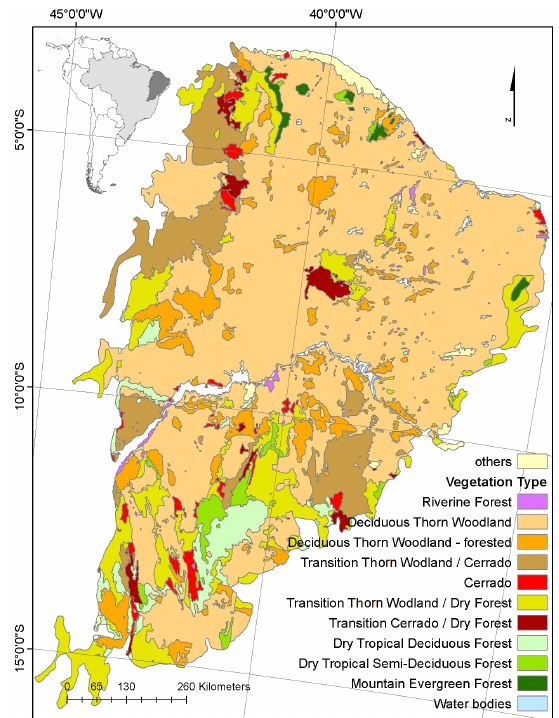
Figure 1. Caatinga potential vegetation map showing the distribution of the different physiognomies classifications (adapted from Rocha (2004)). Insert shows the location of the Caatinga region (dark grey) in northeastern Brazil (light grey) located in South